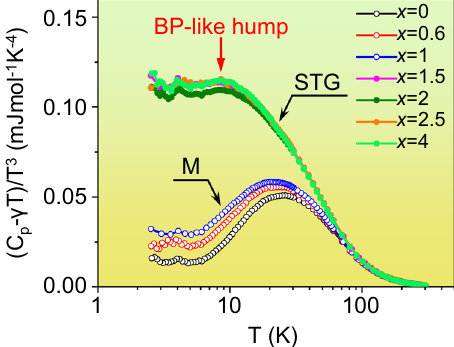
Fig. 2 BP-like anomaly of strain glass in the reduced speci fi c heat ( C p – γ T )/ T 3 as a function of T . The hump of strain glasses around 10 K is similar to the boson peak of metallic glass, and thus termed as the BP- like